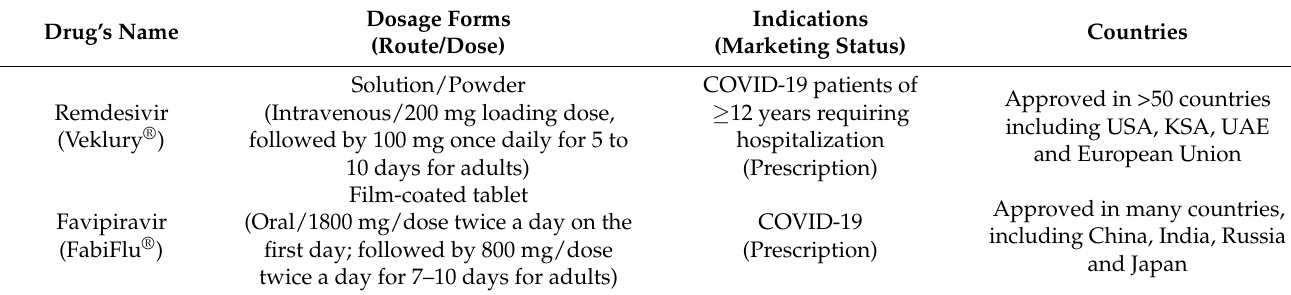
Table 1. Approved RdRp inhibitors in clinical practice.